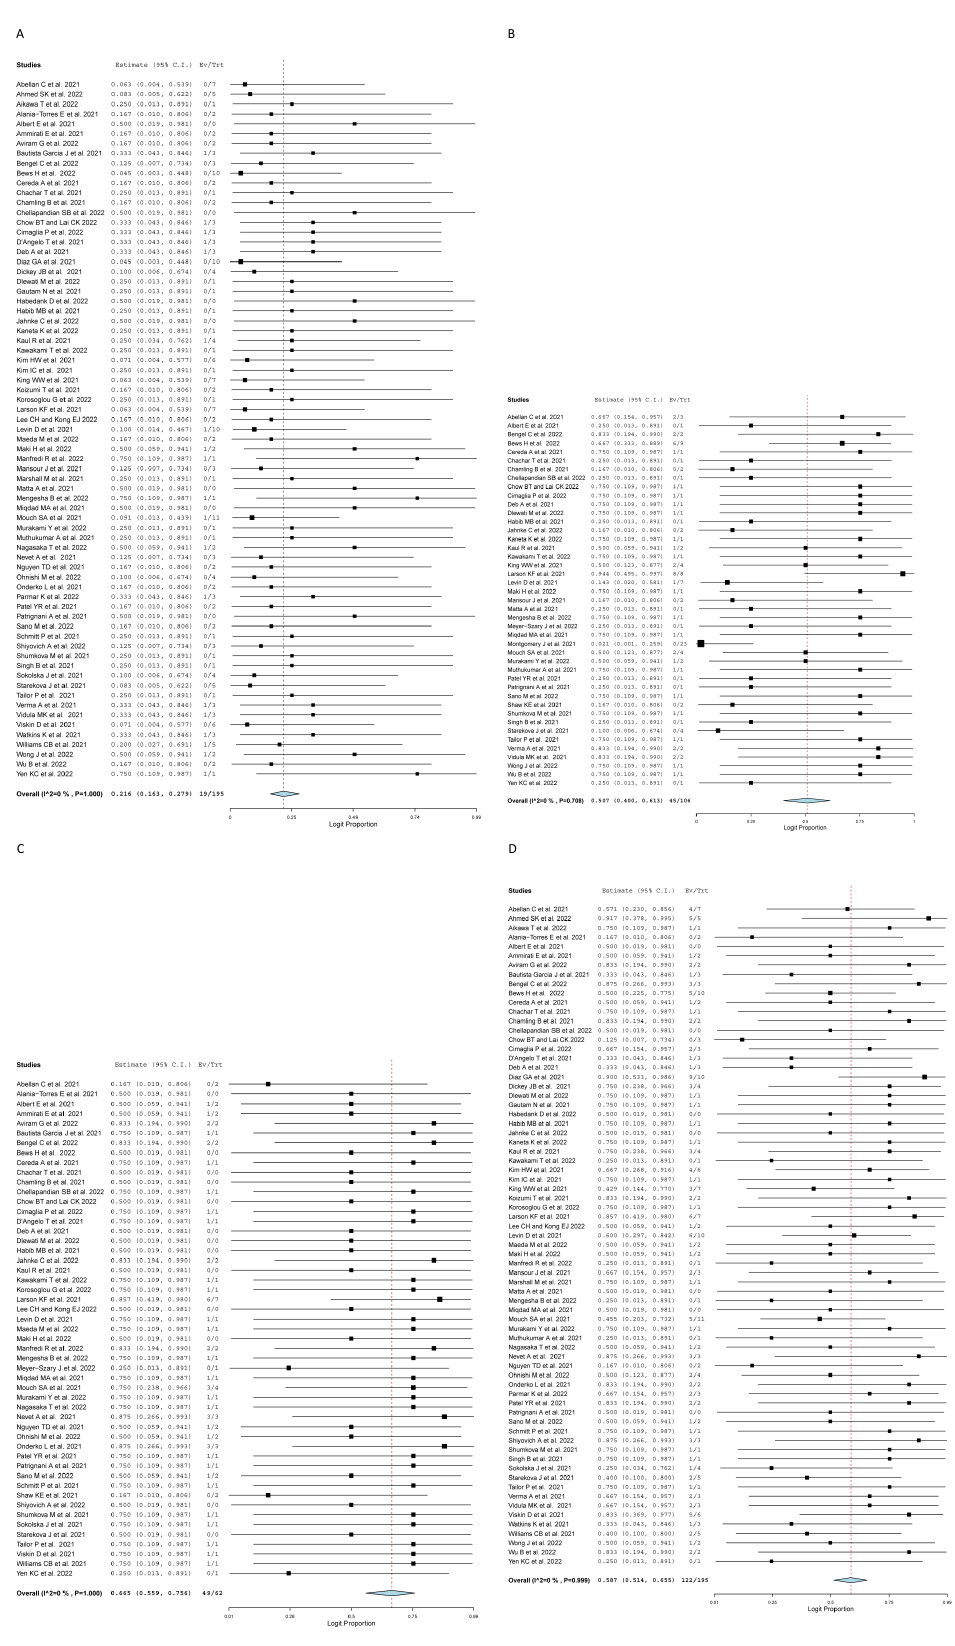
Figure 2. Forest plot of radiological findings at time of admission. ( A ) Arrhythmia. ( B ) Hypokinesis. ( C ) Myocardial Edema. ( D ) ST Changes